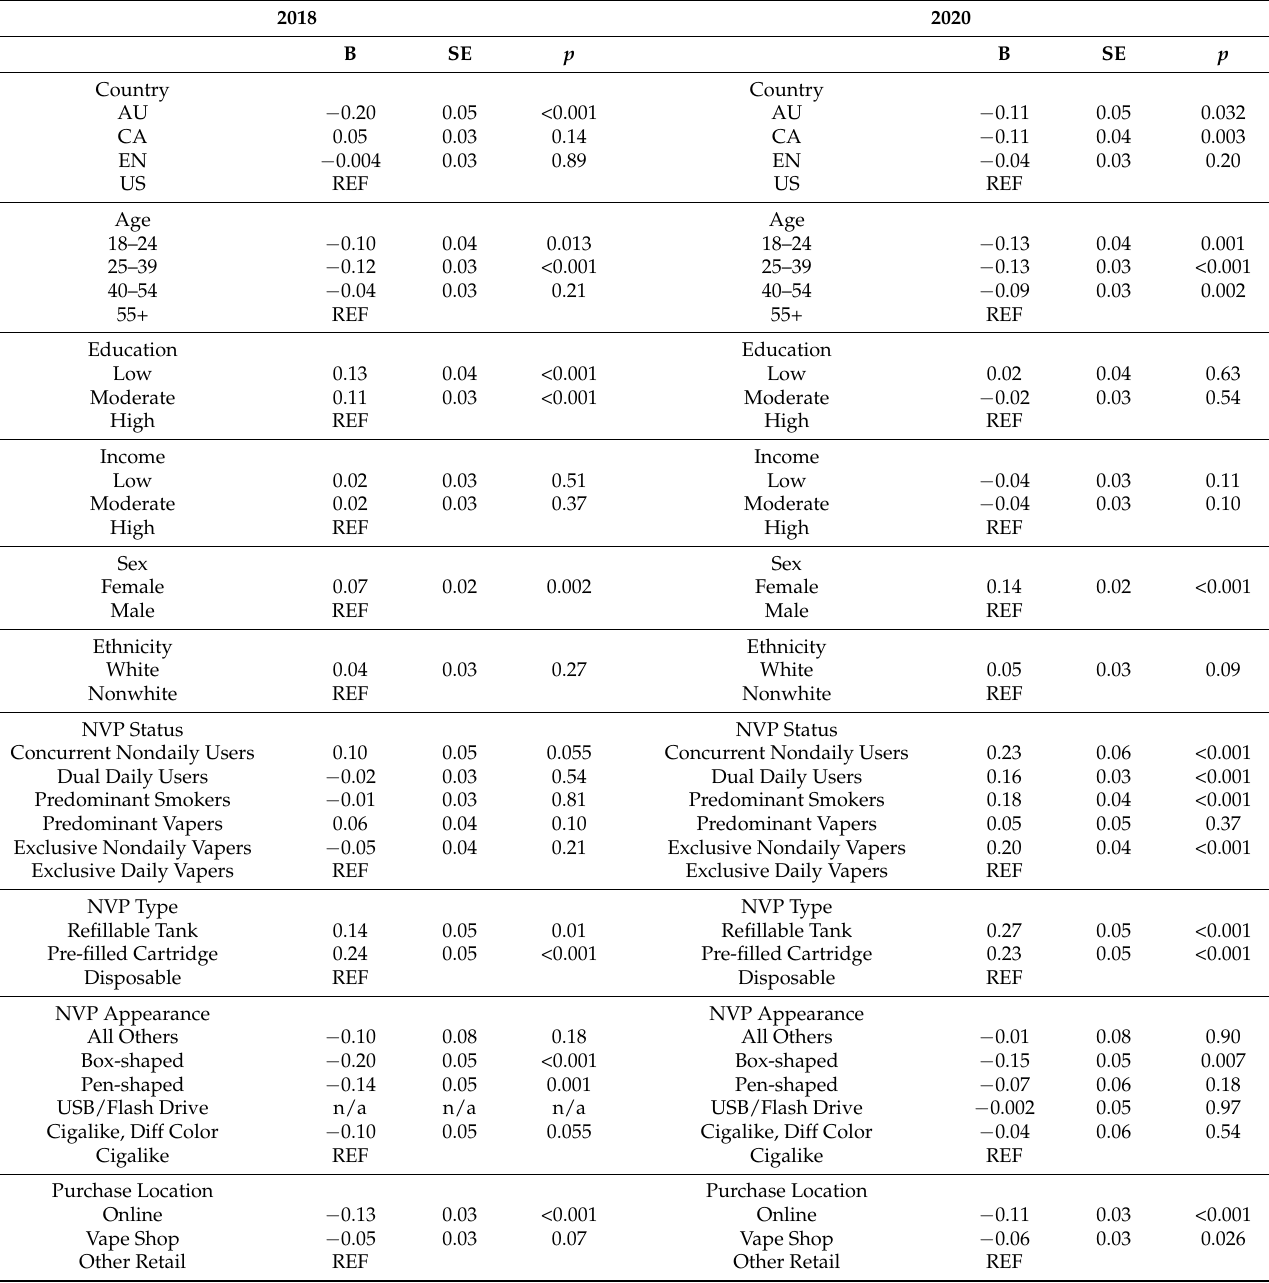
Table 5. Regression models to predict DK index scores in 2018 and 2020. Bolded values indicate significant predictors ( p <